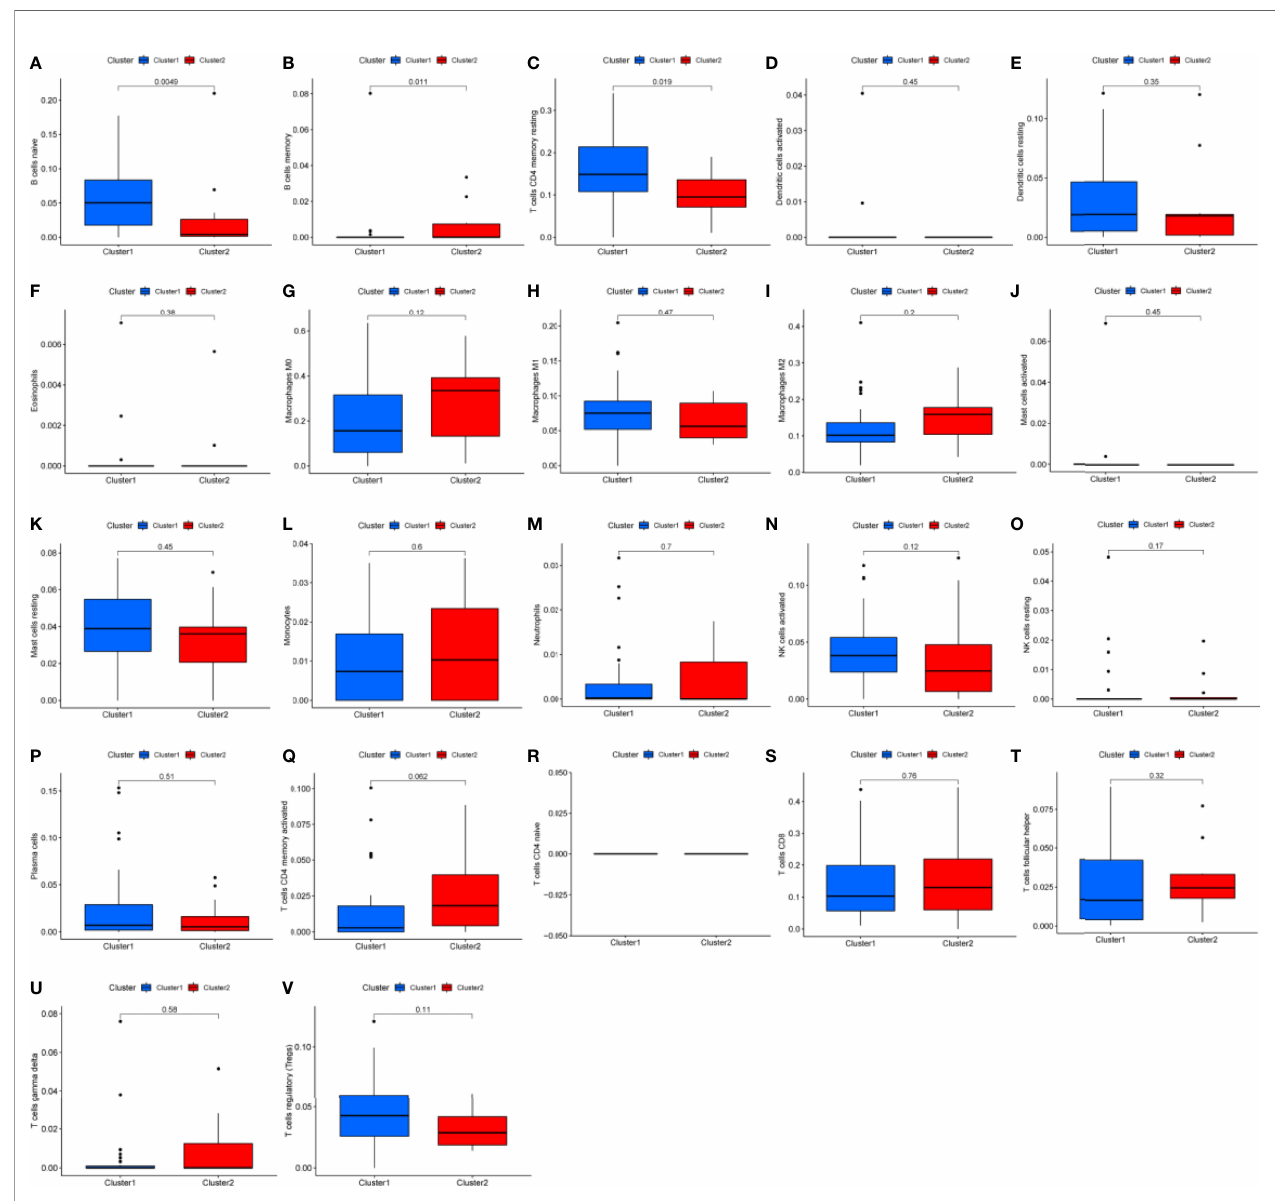
FIGURE 3 | Box plots of differential analysis by immune cells. (A – V) Box plots of differential analysis of B cell, T cell, dendritic cell, eosinophils, macrophages, mast cells, monocytes, neutrophils, natural killer cell, and plasma cells,